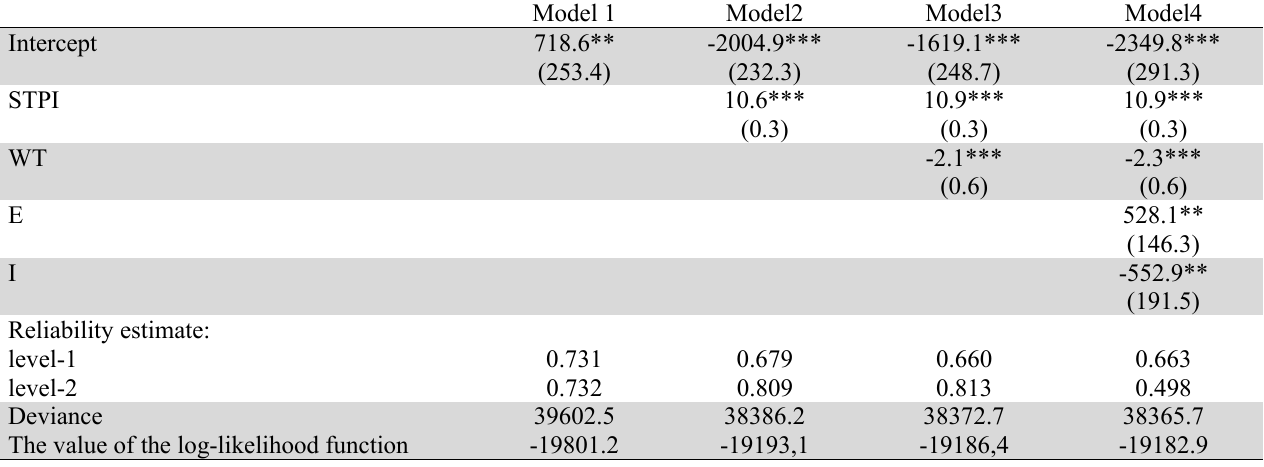
Results of multivariate HLM regression analysis